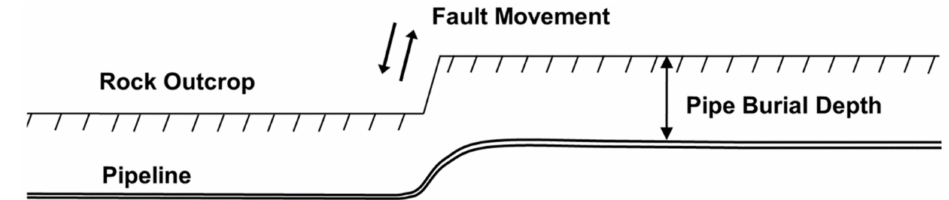
Figure 1. Pipeline laid directly on bedrock, subjected to fault rupture.